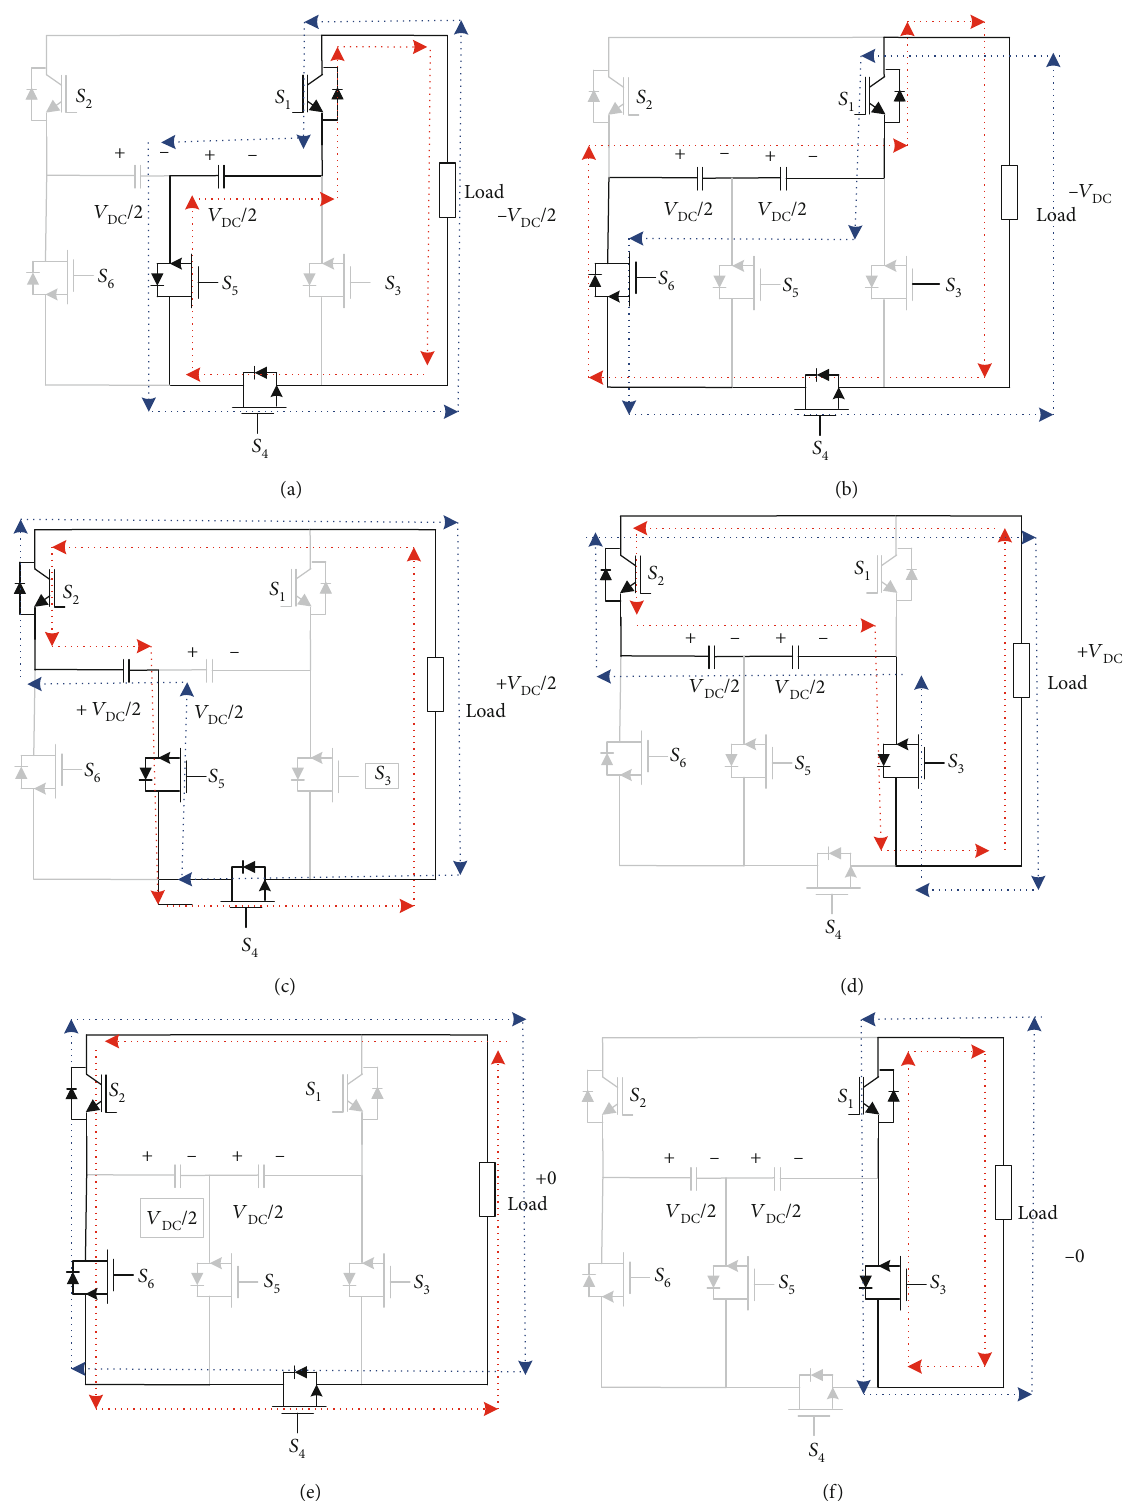
Figure 2: Γ u inverter operation in the following vectors: (a) - V zero